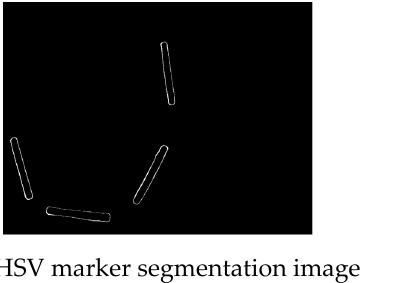
( b ) Marker-contour-detection result Figure 8. Image-thresholding segmentation and contour-detection results.